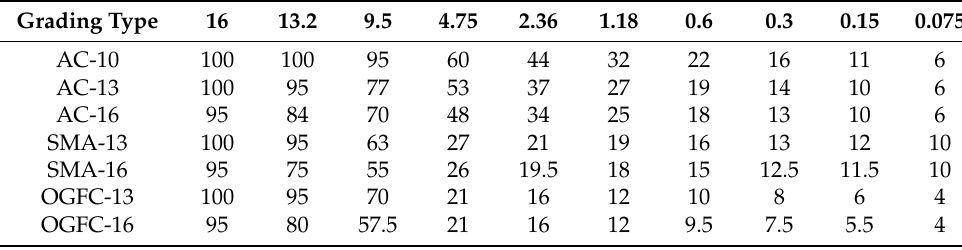
Table 4. Gradations for various asphalt mixtures